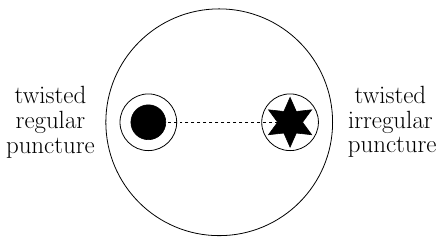
Figure 2 . The sphere with one twisted regular puncture and one twisted irregular puncture that engineers a Class S SCFT of type A 2 N with Z 2